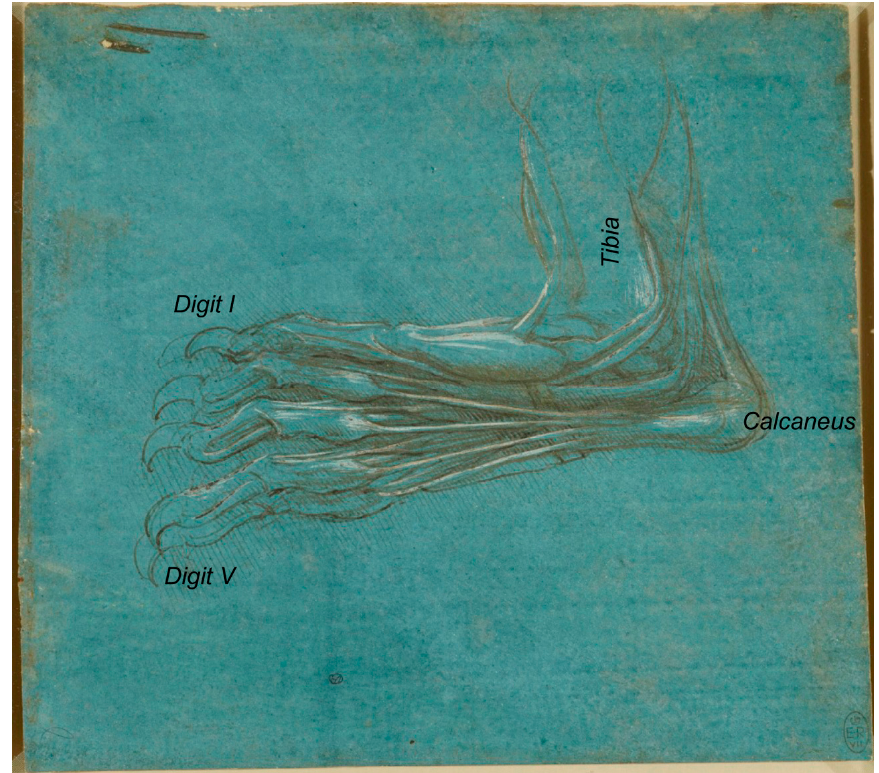
Figure 5. Bear’s foot series—Number 4. Bear distal right pelvic limb/ pes , plantaromedial oblique view. A bear’s foot c.1488–1490. Modified from www.rct.uk/collection/912375 (Royal